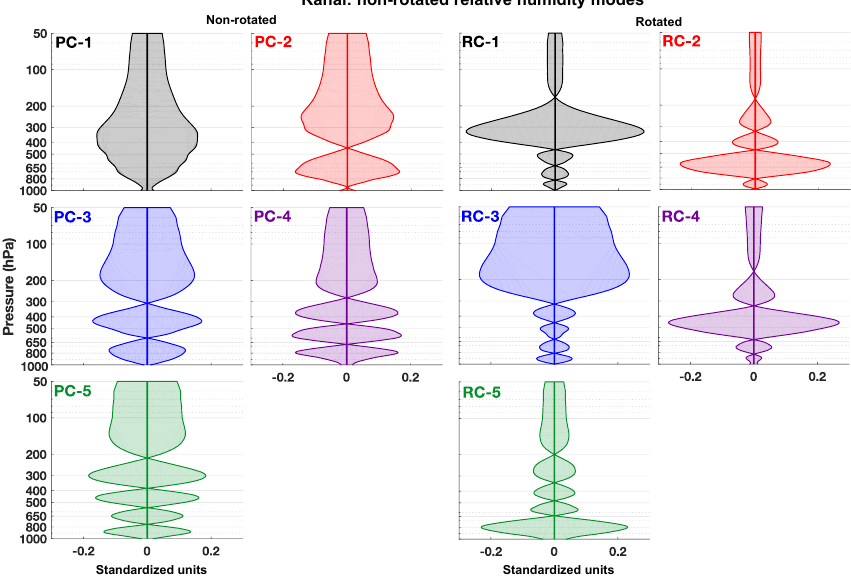
Figure 7. Non-rotated PCs (left panels) and rotated relative humidity RCs (right panels) at the Ranai upper-air sounding site. Bold lines indicate the zero line and the positive and negative values of the eigenvectors. The shaded area represents the total spread of